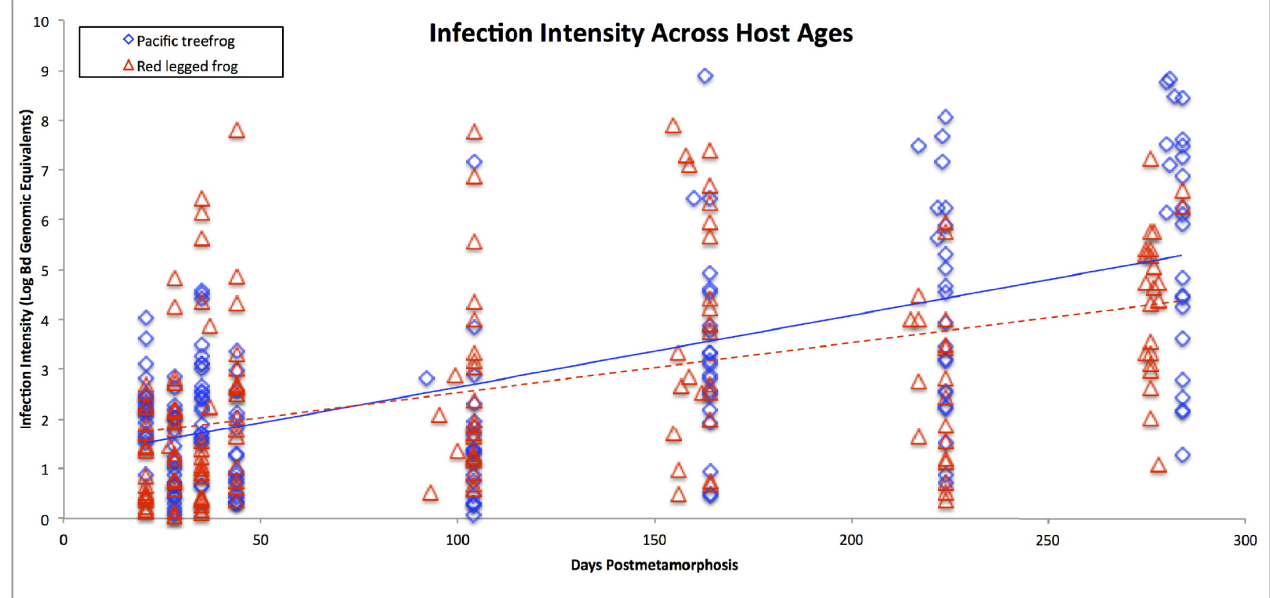
Fig 1. Batrachochytrium dendrobatidis (Bd) infection intensity measured at death over eight trials. Bd exposure trials were performed on frogs that differed in age by approximately one week (1-, 2-, 3-weeks post-metamorphosis) through the first month post-metamorphosis, then on frogs that differed in age by approximately 60-days (1-, 3-, 5-, 7-, 9-months post-metamorphosis).